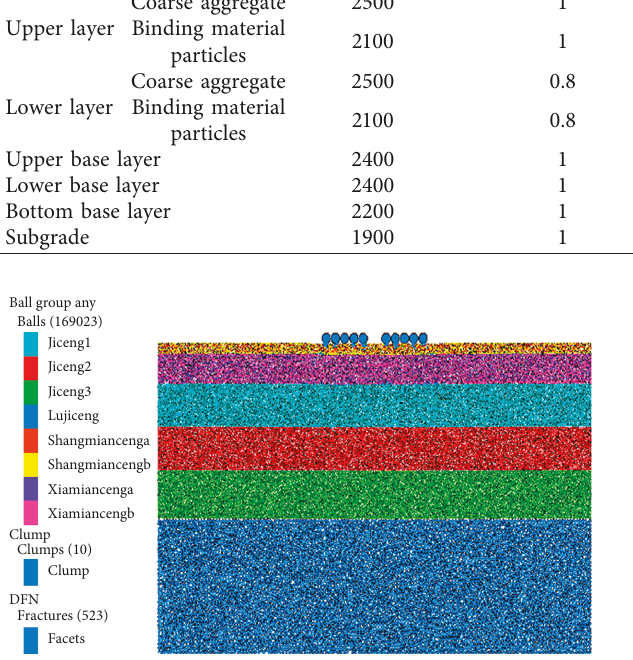
Figure 7: Microcrack shape in 1second.